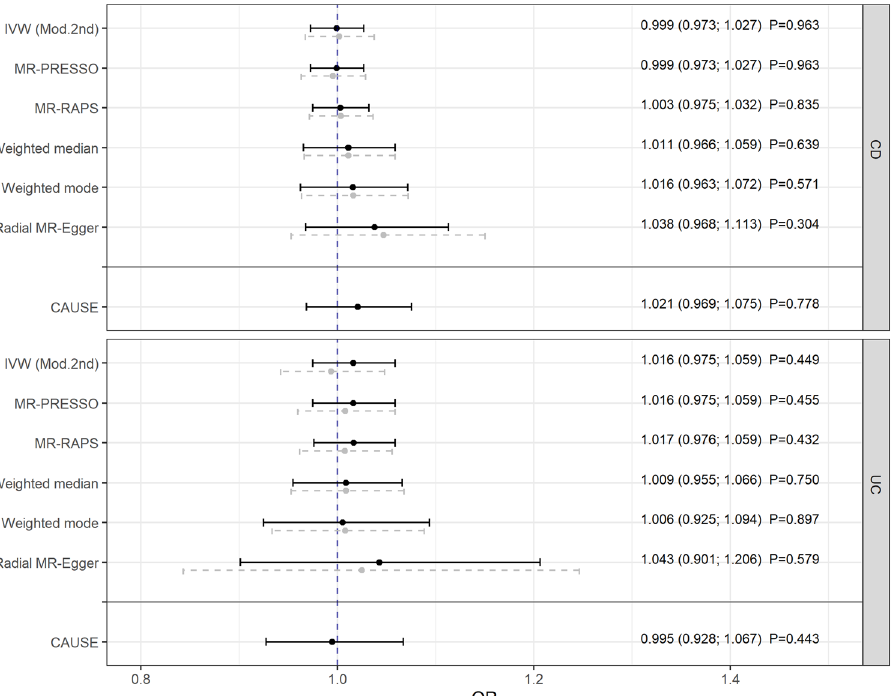
Fig. 3 Mendelian randomization estimates given as odds ratios (ORs) and 95% con fi dence intervals for the causal effect of genetically predicted Crohn ’ s disease (CD) and ulcerative colitis (UC) on Parkinson ’ s disease (PD). The ORs can be interpreted as the average change in the outcome per 2.72-fold increase in the prevalence of the exposure. Dashed gray lines represent the results before and black lines the results after outlier